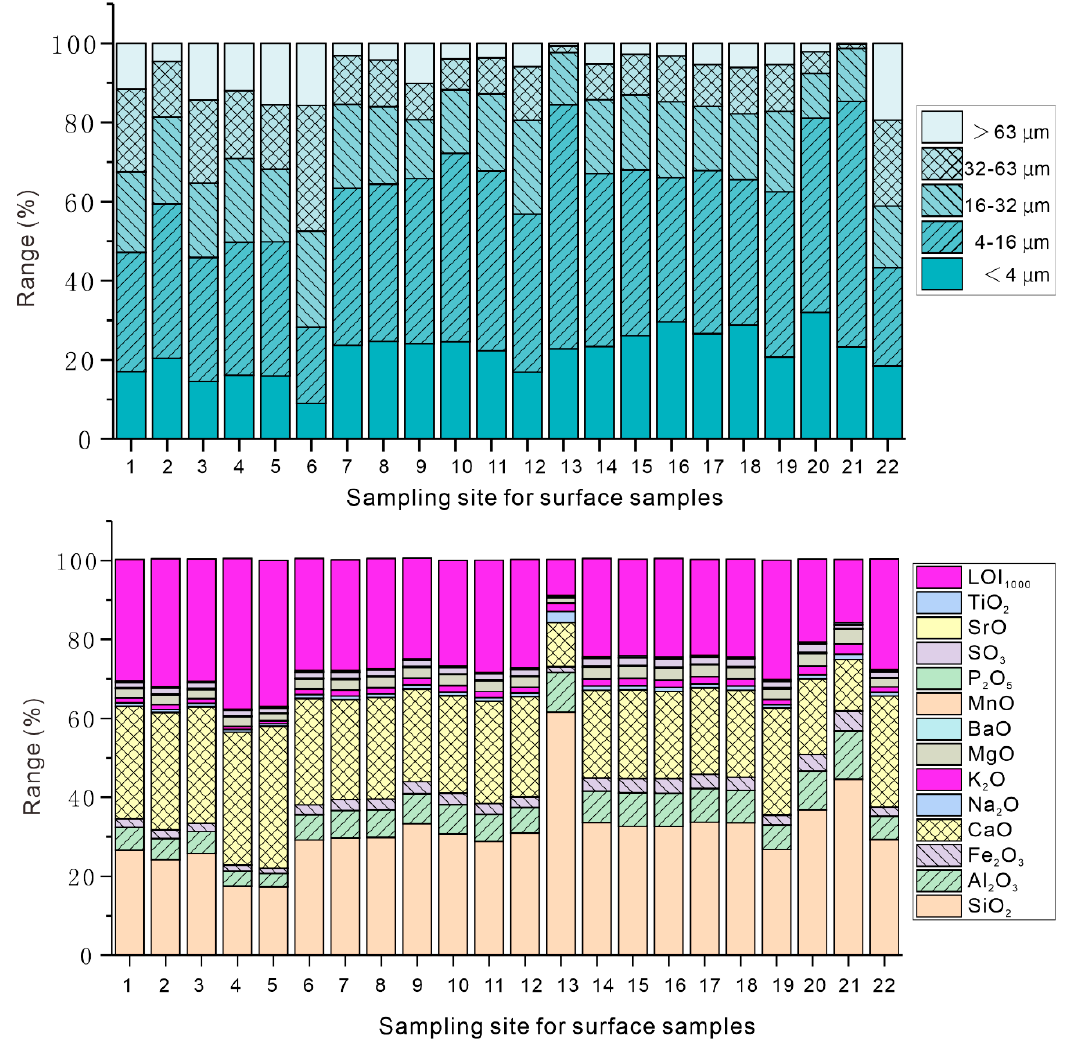
Figure 3. The grain size composition (upper) and bulk-rock analysis (lower) results for the surface sediments of Lake Bosten.